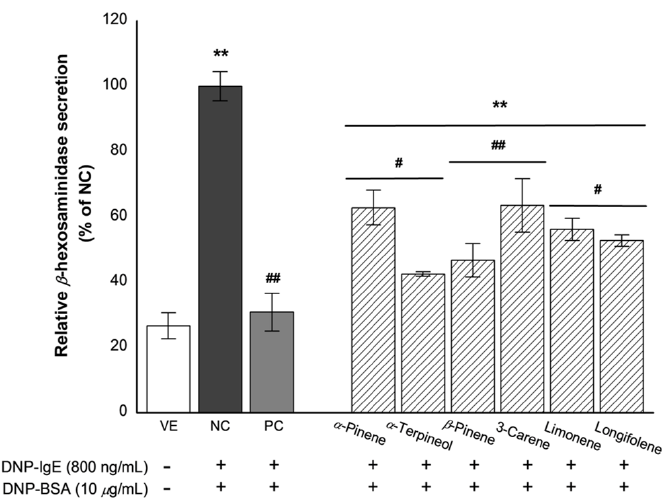
Figure 7. Inhibition effect of the single compounds on β -hexosaminidase release. VE: vehicle, DMSO; NC: negative control, 800-ng/mL DNP-IgE and 10- µ g /mL DNP-BSA treated group; PC: positive control, 100-nM dexamethasone treated group, the single compounds (10 − 7 %). Values are presented as mean ± standard deviation. ** p < 0.01 compared with VE; # p < 0.05, ## p < 0.01 compared with NC.